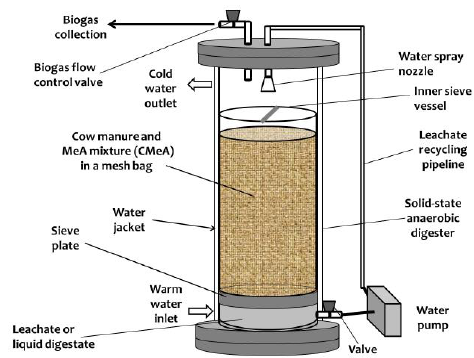
Figure 1. Design of the SSAD reactor.